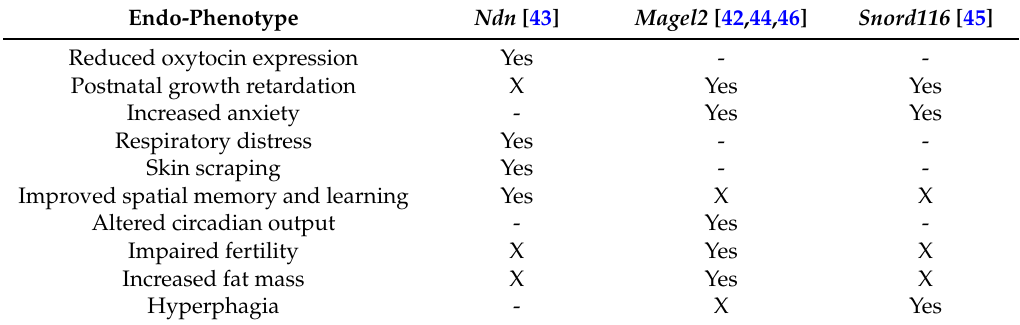
Table 4. Phenotypic characteristics of single gene or gene cluster deletion mouse models of PWS.